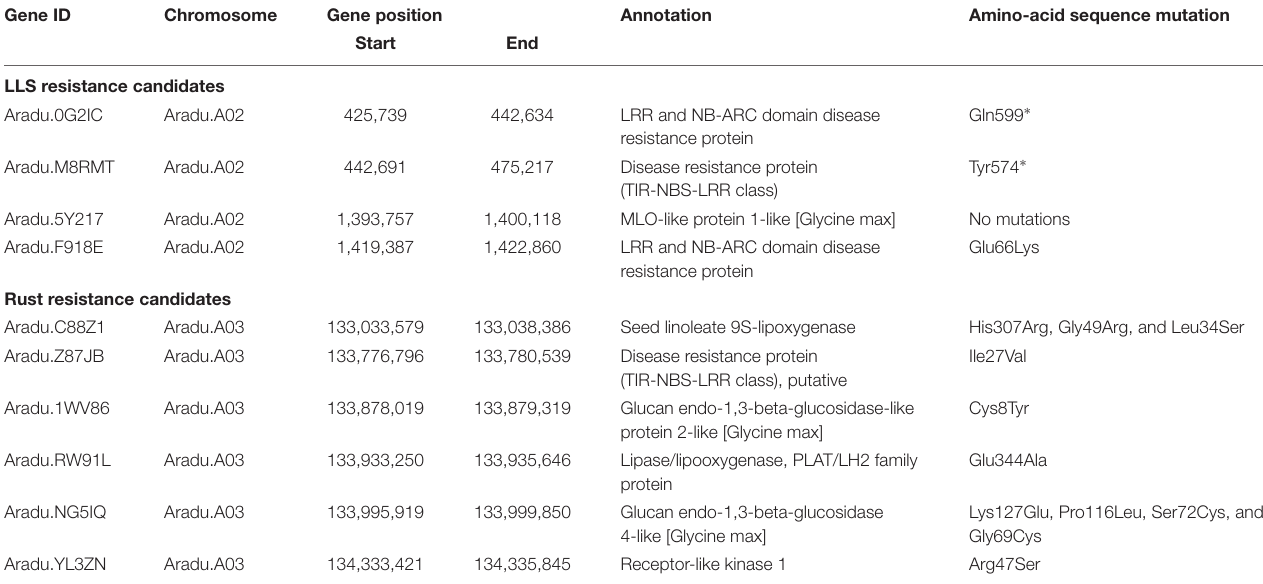
TABLE 1 | Candidate genes for LLS and rust